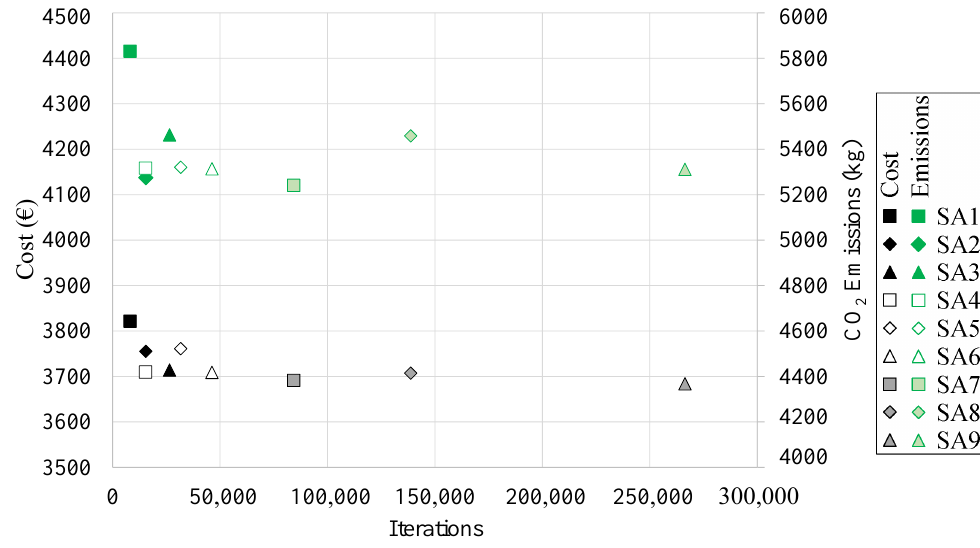
Figure 8. Minimum final cost and associated CO 2 emissions obtained by the SA